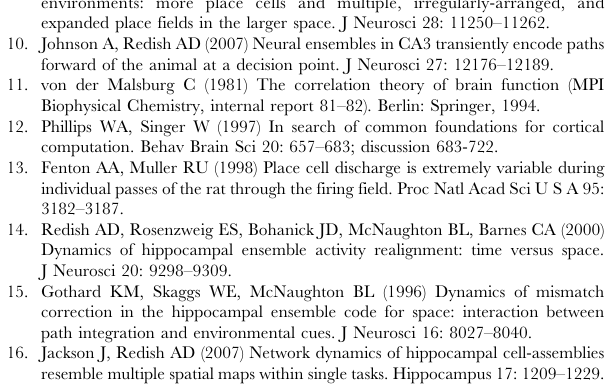
Figure S7 The waveform discrimination of the units shown in Figure 3A. Cells recorded from two tetrodes were discriminated based on the amplitude and other parameters of the waveform on the four tetrode channels. Example action potential waveforms are shown on the right. Figure S8 The waveform discrimination of the units shown in Figure 3B. Cells recorded from two tetrodes were discriminated based on the amplitude and other parameters of the waveform on the tetrode channels. Example action potential waveforms are shown on the right. Figure S9 Ensemble dynamics of frame preference during two-frame avoidance, as shown on Figure 2F, zoomed in on a shorter timescale. Ensemble I pos was computed as the difference between room and arena I pos during 117 ms intervals for each cell summed across all cells in a single recording. Positive values (red) indicate ensemble preference for the room frame; negative values (blue) indicate preference for the arena frame. Figures A, B, and C show data from three different recordings. Panels A and B are from the same recordings as Figure 2F1 and 2F2, respectively. Figure S10 Comparison of session-averaged spatial frame preferences and session-averaged behavior. (Left) The proportion of room and arena preferring cells during two- frame avoidance sessions was not related to the relative proportion of entrances to the room shock zone and the arena shock zone. (Right) The average relative distance to the two shock zones was also not related to the ensemble spatial frame preference. Figure S11 Three parameters that were used to quan- tify spatially selective firing of place cells. (A) Firing rate maps of seven neurons, these neurons were chosen so that cells with well-organized firing fields and cells with spatially disorga- nized firing are represented. The scatter plots in (B) and (C) show spatial coherence, mean momentary positional information ( I pos ), and information content of all recorded cells. The points representing the neurons shown in (A) are marked by colors